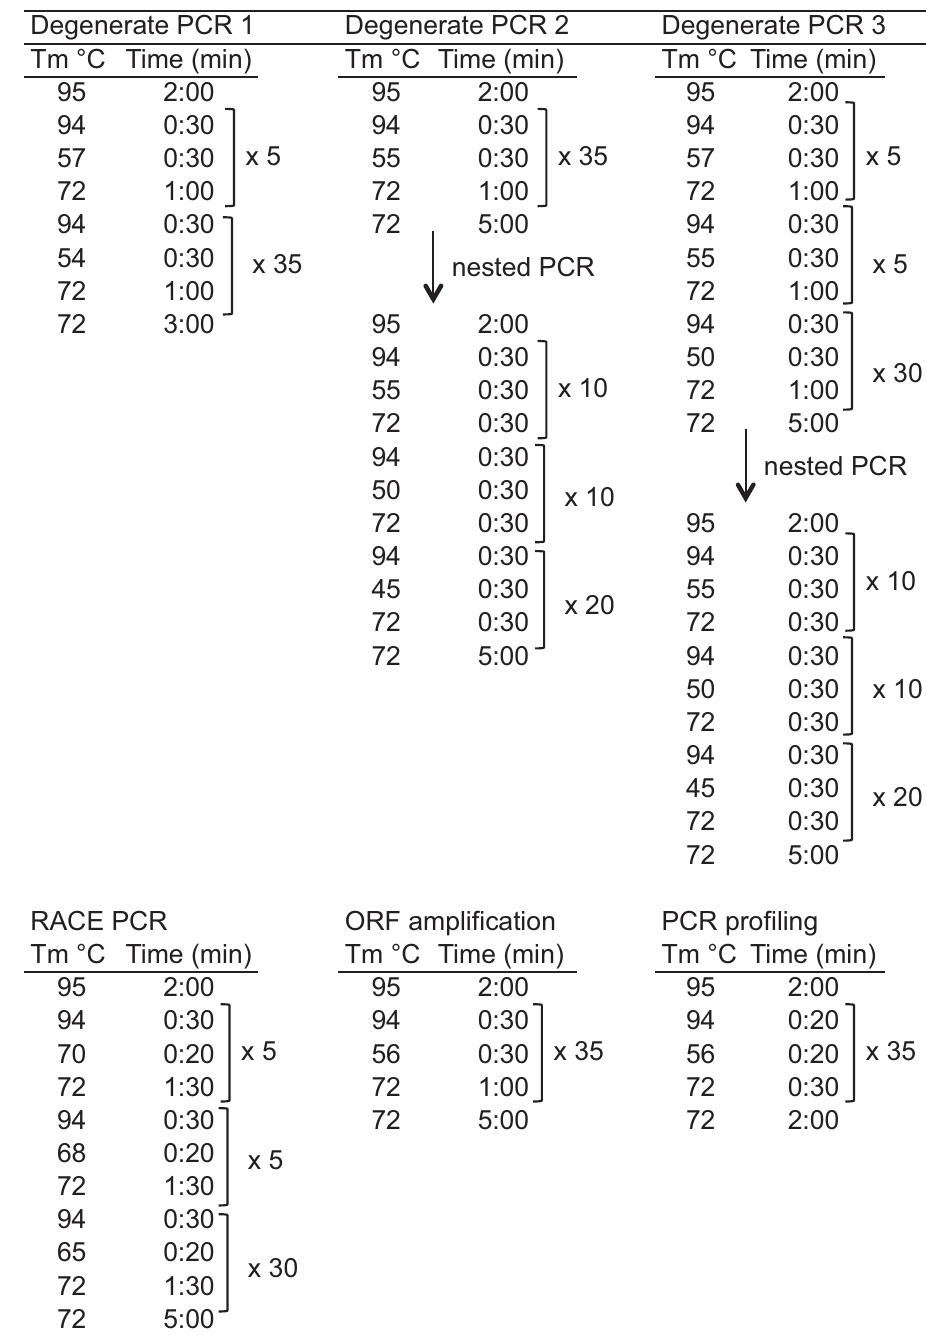
Figure 1. Thermocycler conditions